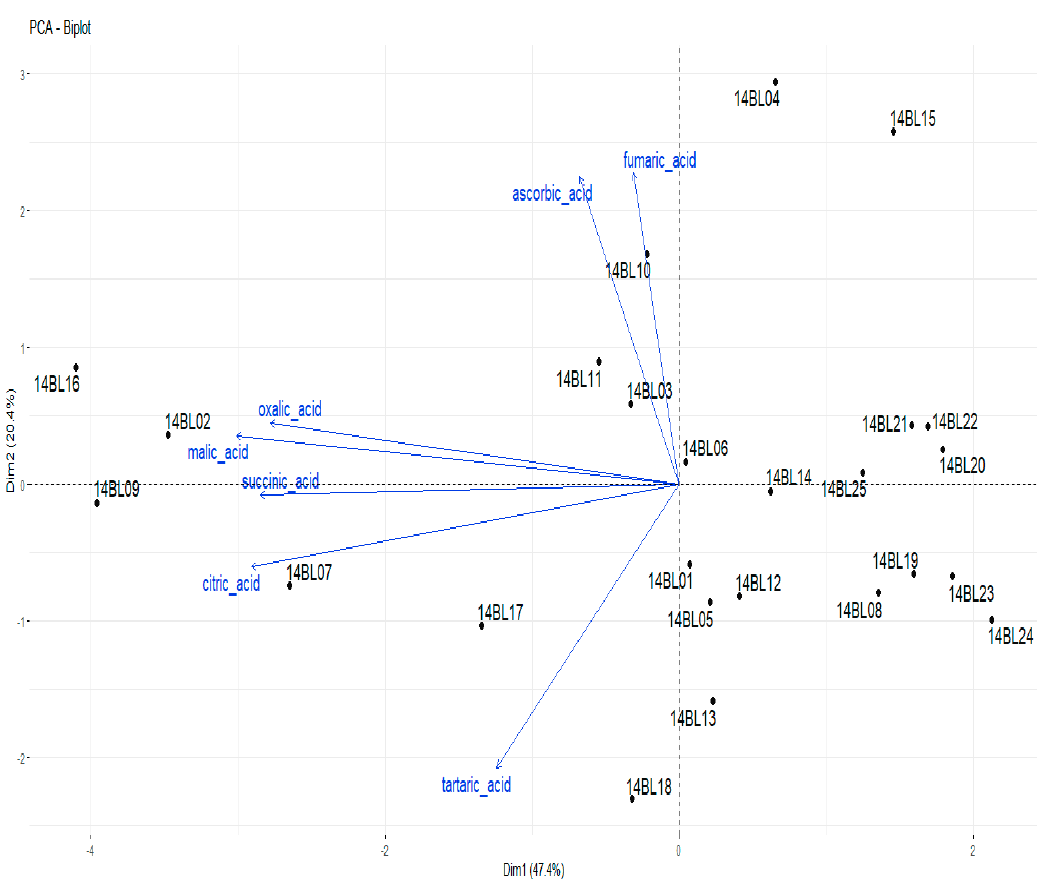
Figure 1. Diversity of genotypes in terms of organic acid content by PCA (Principal Component Analysis) analysis.